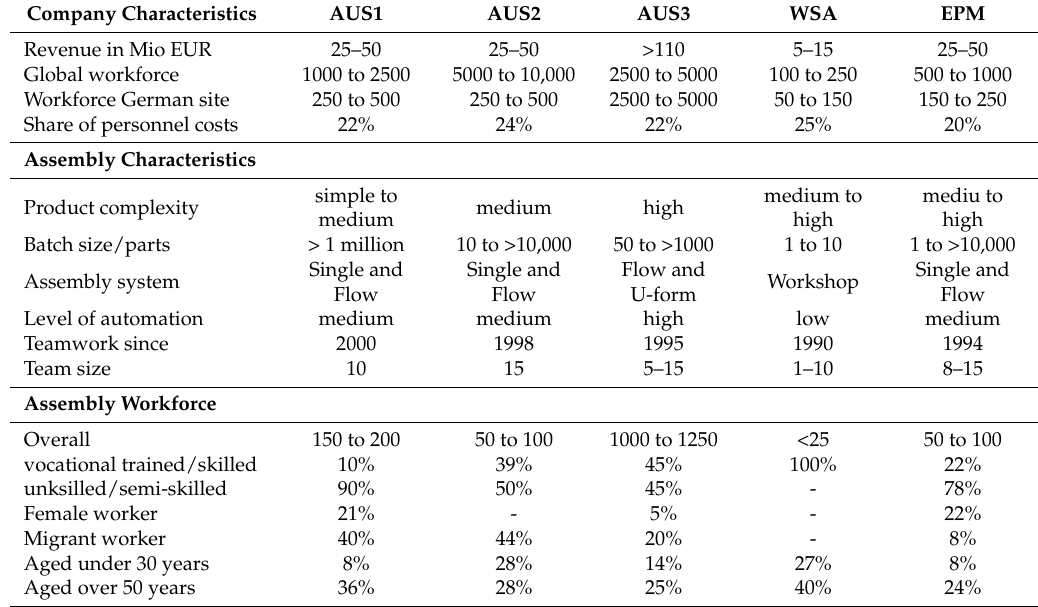
Table 3. Company and workforce characteristics of case